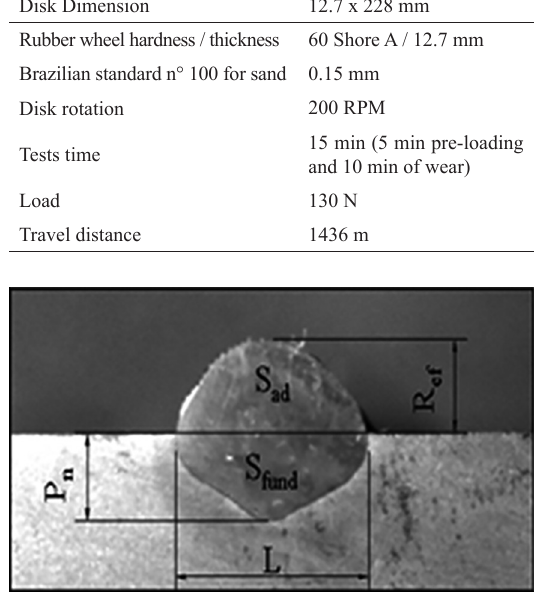
Figure 4: Weld bead image on a layer and the components to calculate the dilution 6 . The dilution calculation was done by the relationship between the welded area and the total area of the weld bead, according to equation